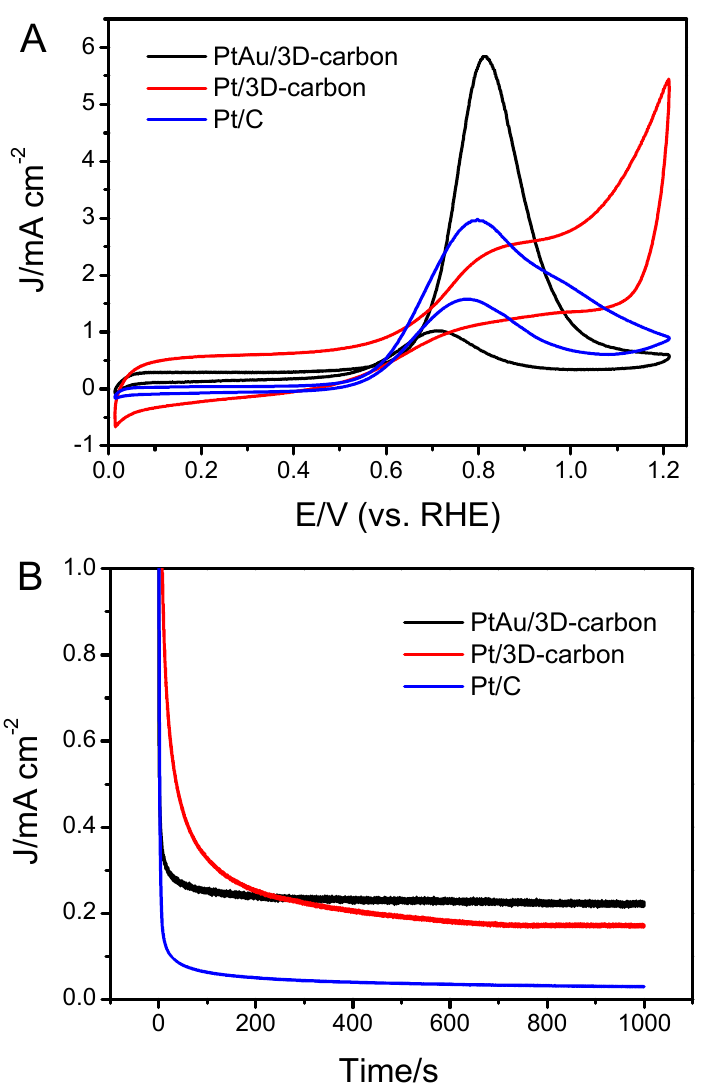
Figure 4. ( A ) Cyclic voltammograms and ( B ) i–t curves (at 0.7 V vs. RHE) of PtAu/3D carbon and commercial Pt/C in 0.1M NaOH + 1M CH 3 OH solution with a scan rate of 50 mV s − 1